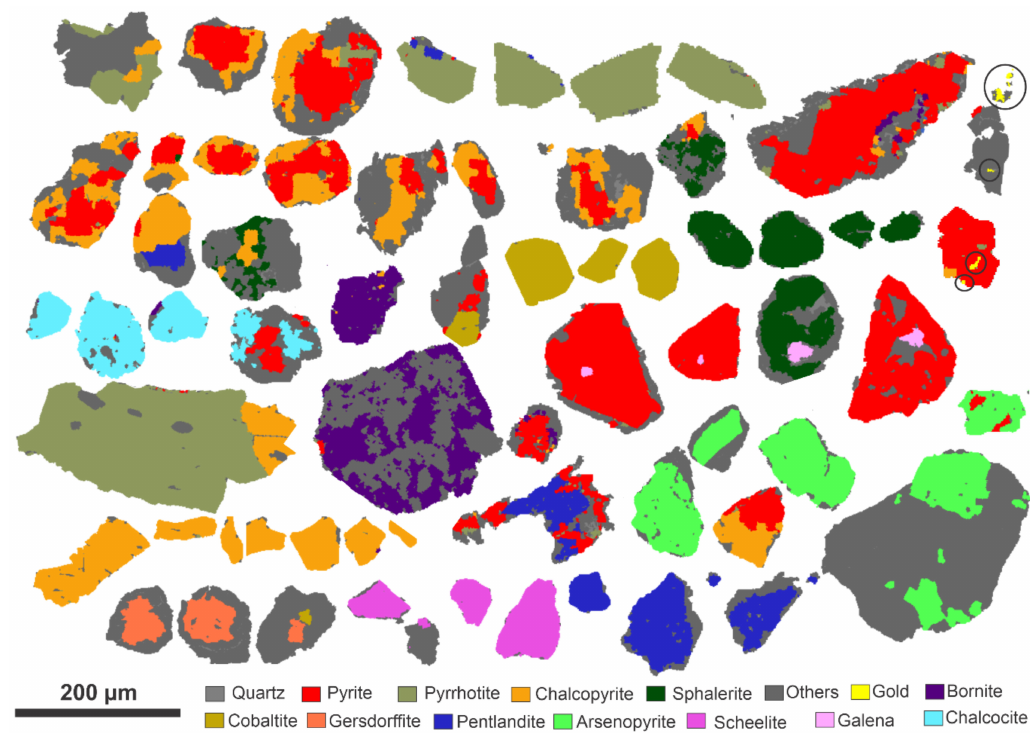
Figure 12. TIMA SEM mineral map of gold- and sulfide-containing particles at the base of the Permian cover. Gold (black circles) and sulfides exist mainly in angular composite grains and subhedral and euhedral liberated grains.